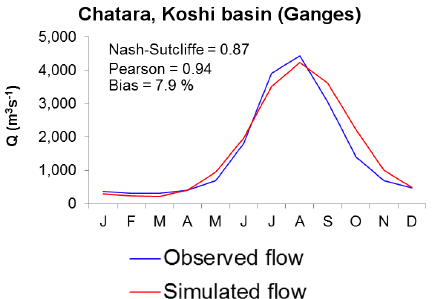
Figure 6. Average monthly observed and SPHY-simulated flow (1998–2007) for the Chatara major discharge measurement loca- tion in the Ganges basin (Lutz et al., 2014a). Metrics are calculated based on monthly time